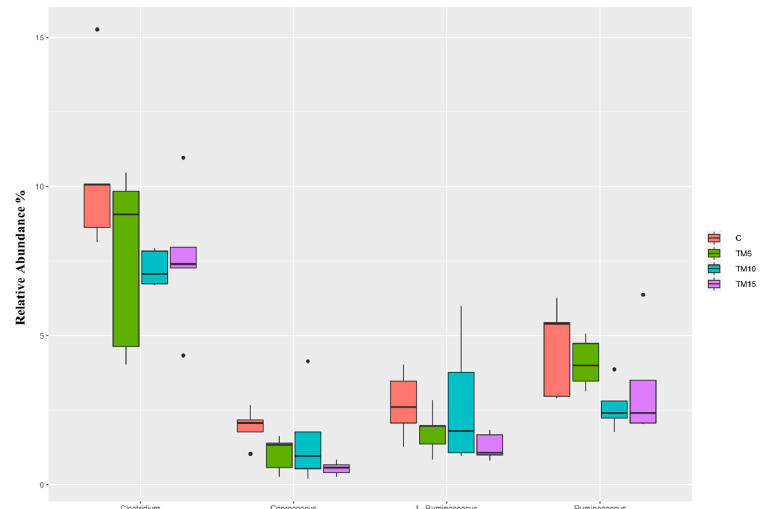
Figure 4. Genera changes (FDR < 0.05) in cecal samples of heavy-size broiler chickens fed control (C), 5% (TM5), 10% (TM10) and 15% (TM15) inclusion level of Tenebrio molitor meal diets.